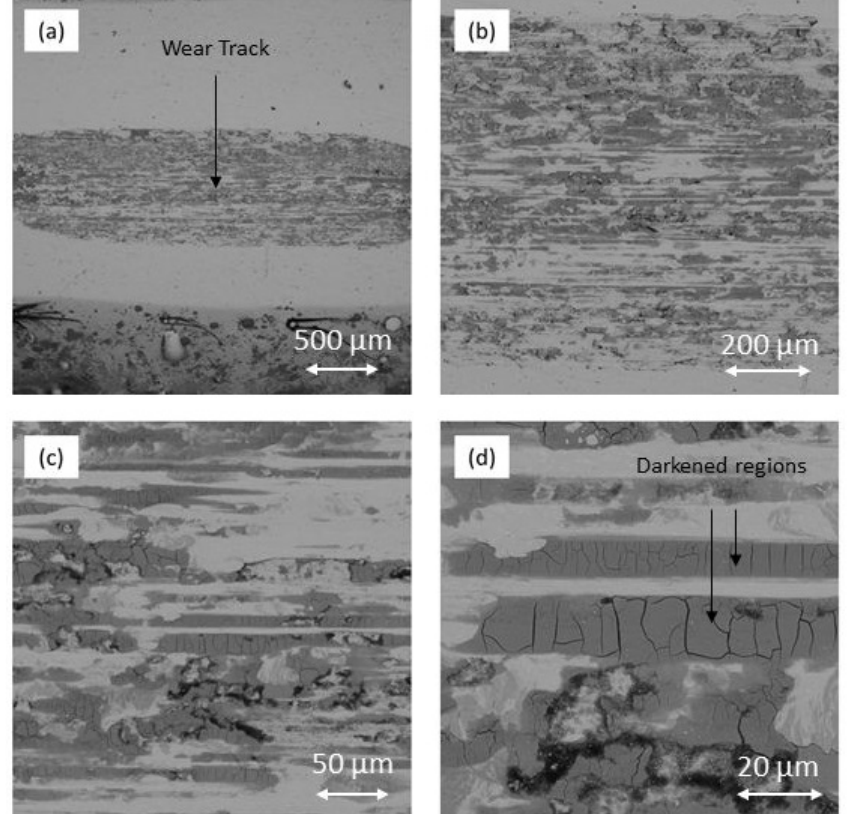
Figure 15. Typical wear tracks of coatings deposited with 1.5 and 4.0 kW on AISI 304L and 1.5kW on